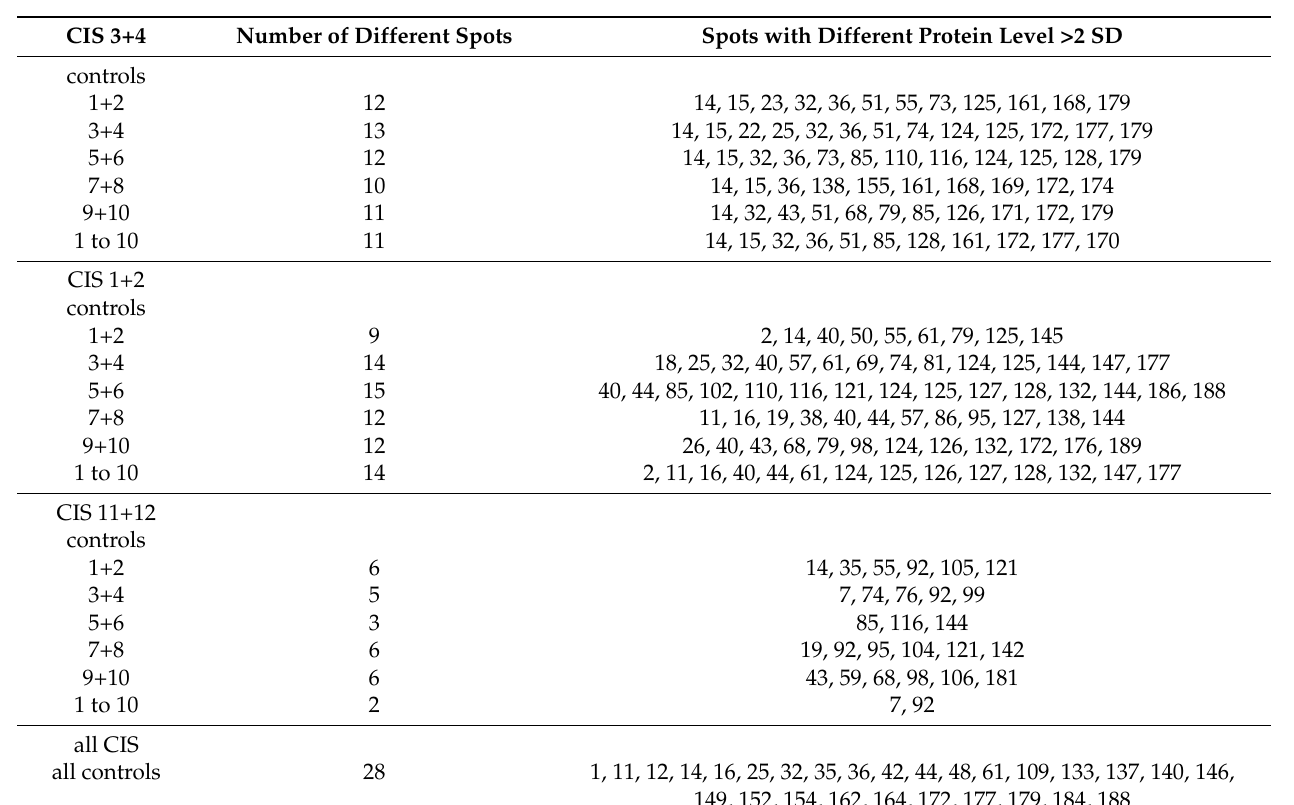
Table 4. Proteins identified with different level by spot number, shown in exemplary matched batch